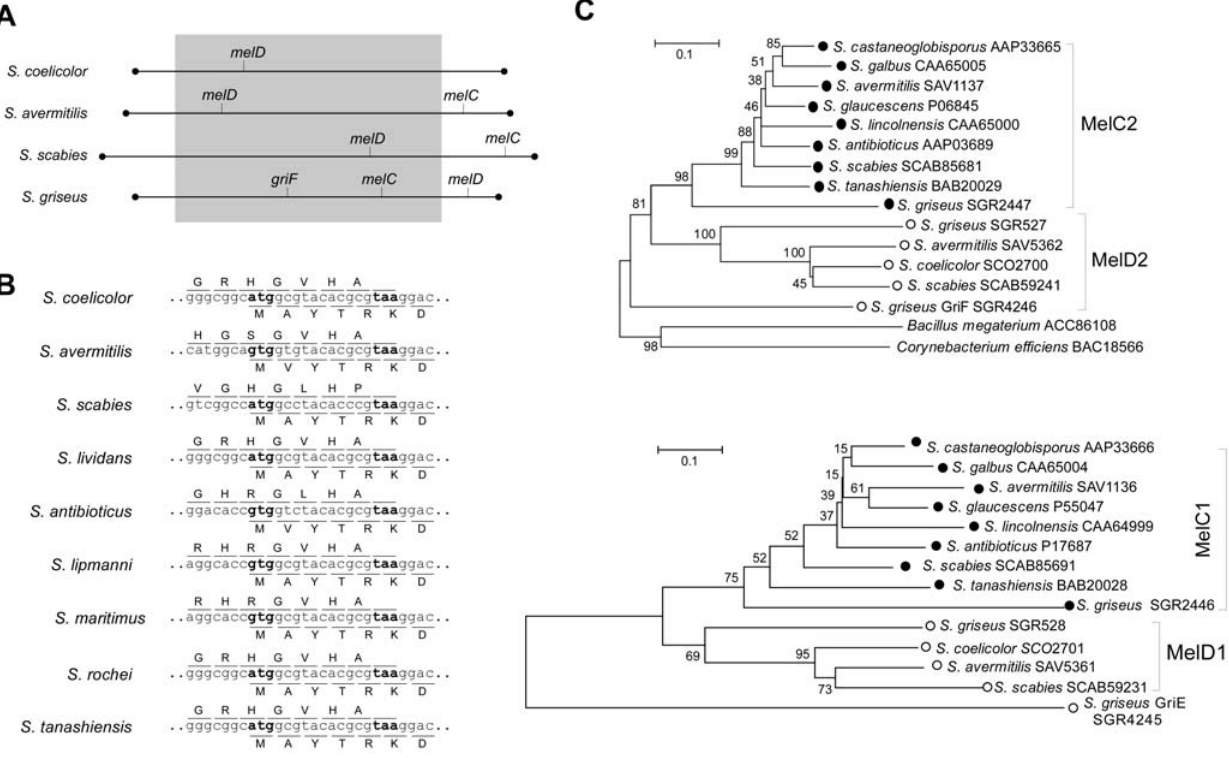
Figure 1. Occurrence of the melC and melD operons. A. Chromosomal locations. The approximate locations of melC and melD on the four sequenced Streptomyces chromosomes are marked. Filled circles, terminal proteins; gray area, approximate ‘core region’ of the chromosomes. B. Overlapping region of melD1 and melD2 . The stop codon of melD1 and the initiation codon of melD2 are in bold face. C. Phylogenetic trees of MelC2 (top) and MelC1 (bottom) homologs. The sequences were aligned using ClustalX version 1.8 with the following parameters: method: accurate; matrix: Gonnet; gap open penalty: 10; gap extension penalty: 0.1. The phylogenetic trees were generated using the Neighbor-Joining method. The bootstrap values (in percentages) from 500 reiterations are shown. The capacity to produce melanin is indicated by filled circles, and the inability to produce melanin by open circles.